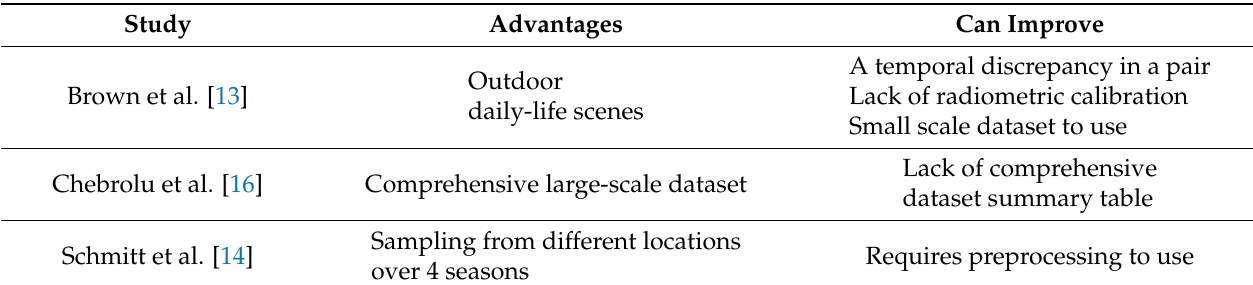
Table 1. Summary of related studies on NIR–RGB